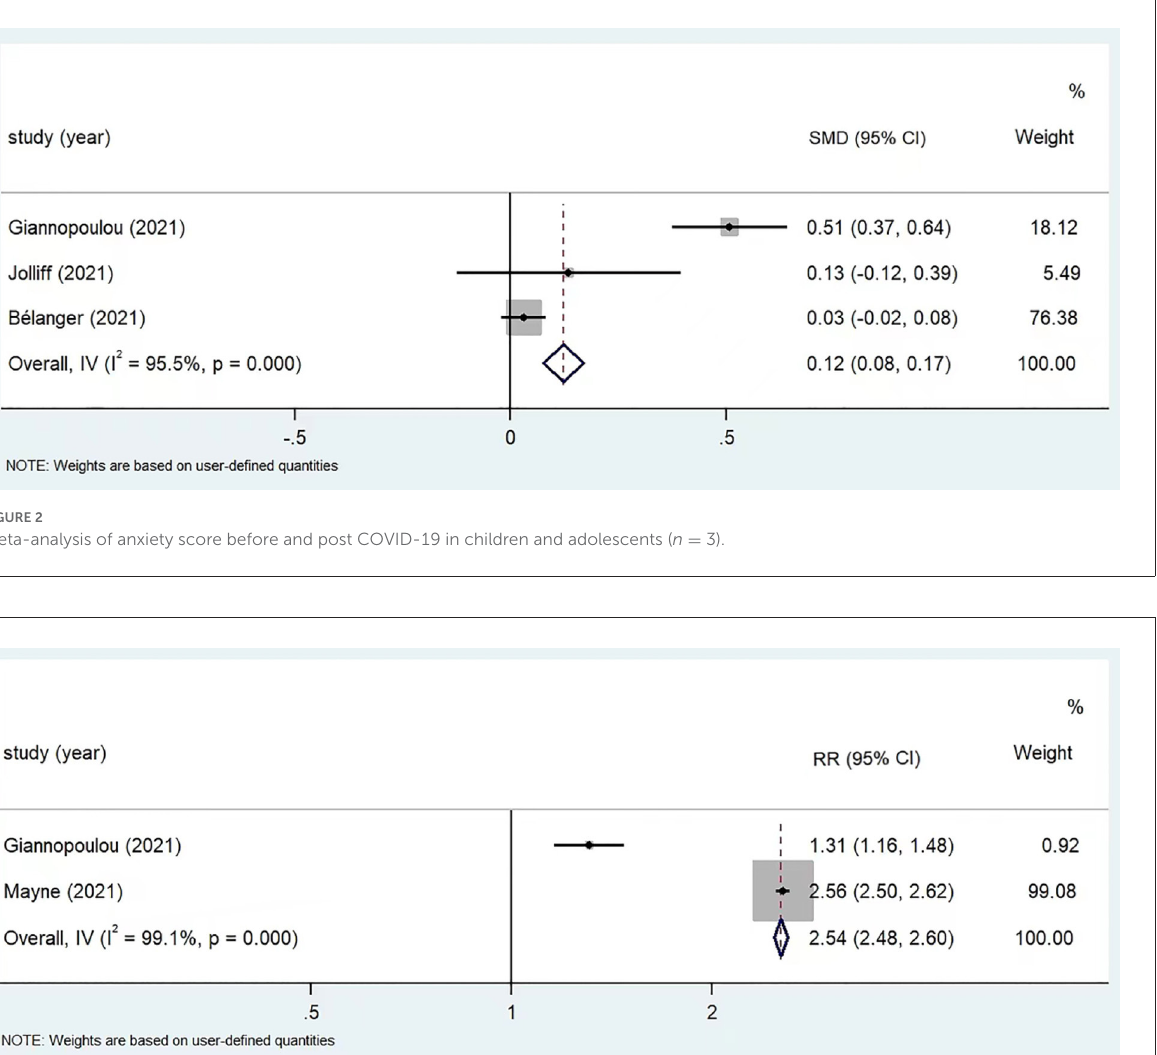
reported prevalence rates of depression, a statistically higher depression rate had been revealed, with RR values of 1.31 (95% CI: 1.16, 1.48) for Giannopoulou et al. (27), 2.56 (95% CI: 2.50, 2.62) for Mayne et al. (32). The combined RR was 2.54 (95% CI: 2.48, 2.60) based on random-effect model ( I 2 = 99.1%, p < 0.05) (Figure 3). Mean and standard deviation for depression scores were reported in 6 articles using PHQ-9, PHQ-8, and MFQ, respectively. The results for subgroup analysis by different measuring scales were collectively shown in Figure 4. For the two studies used PHQ-9, Giannopoulou et al. (27) reported statistically increased depression score in post COVID-19 period, with an SMD of 0.41 (95% CI: 0.28, 0.54), whereas